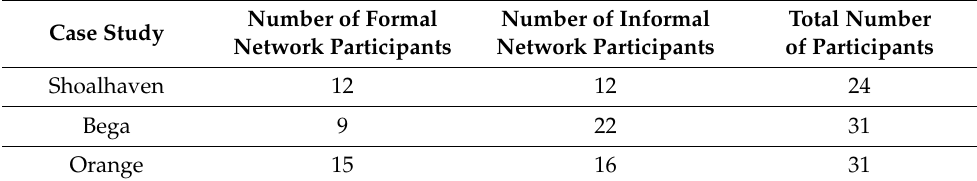
Table 2. Association of participants with formal or informal networks.